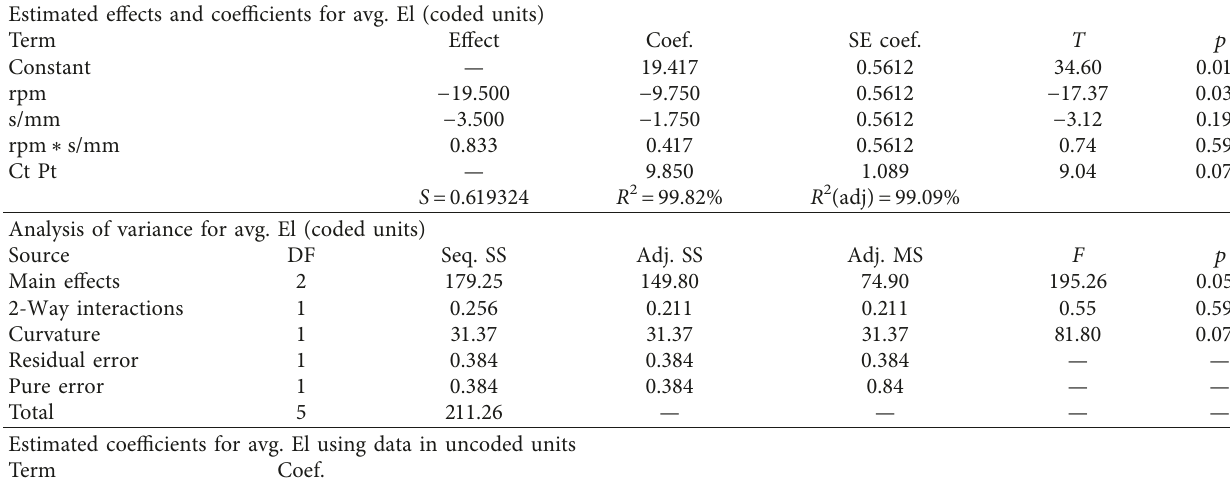
Estimated coefficients for avg. El using data in uncoded units